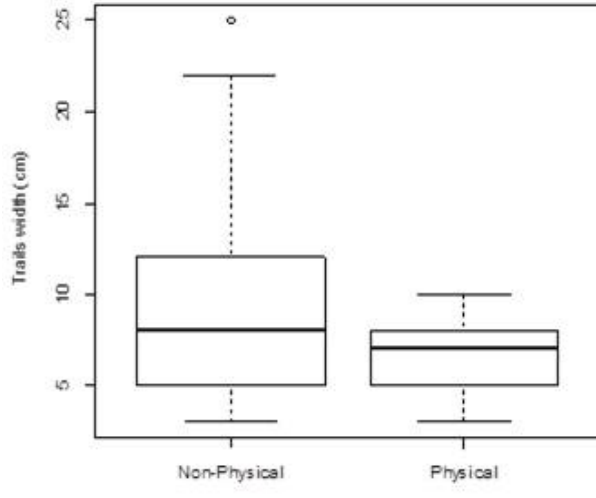
Fig 4 B. Minimum, medium and maximum width of non-physical and physical